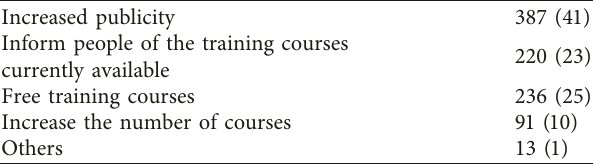
Table 6: The effective method in students’ opinion to increase public awareness about